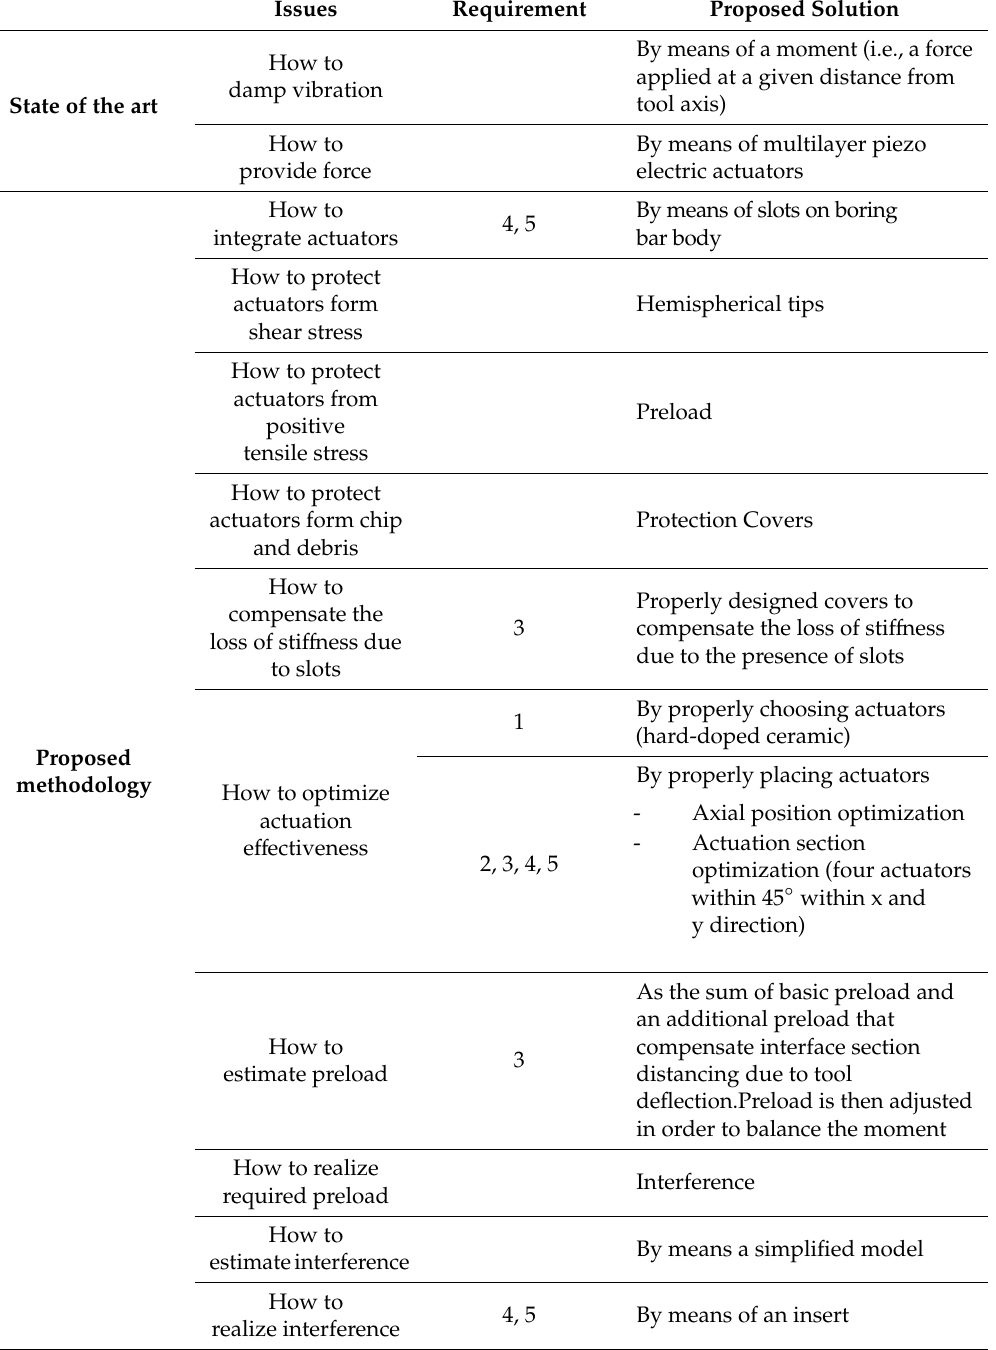
Table 1. Issues, requirements and proposed solution for the design of an active boring